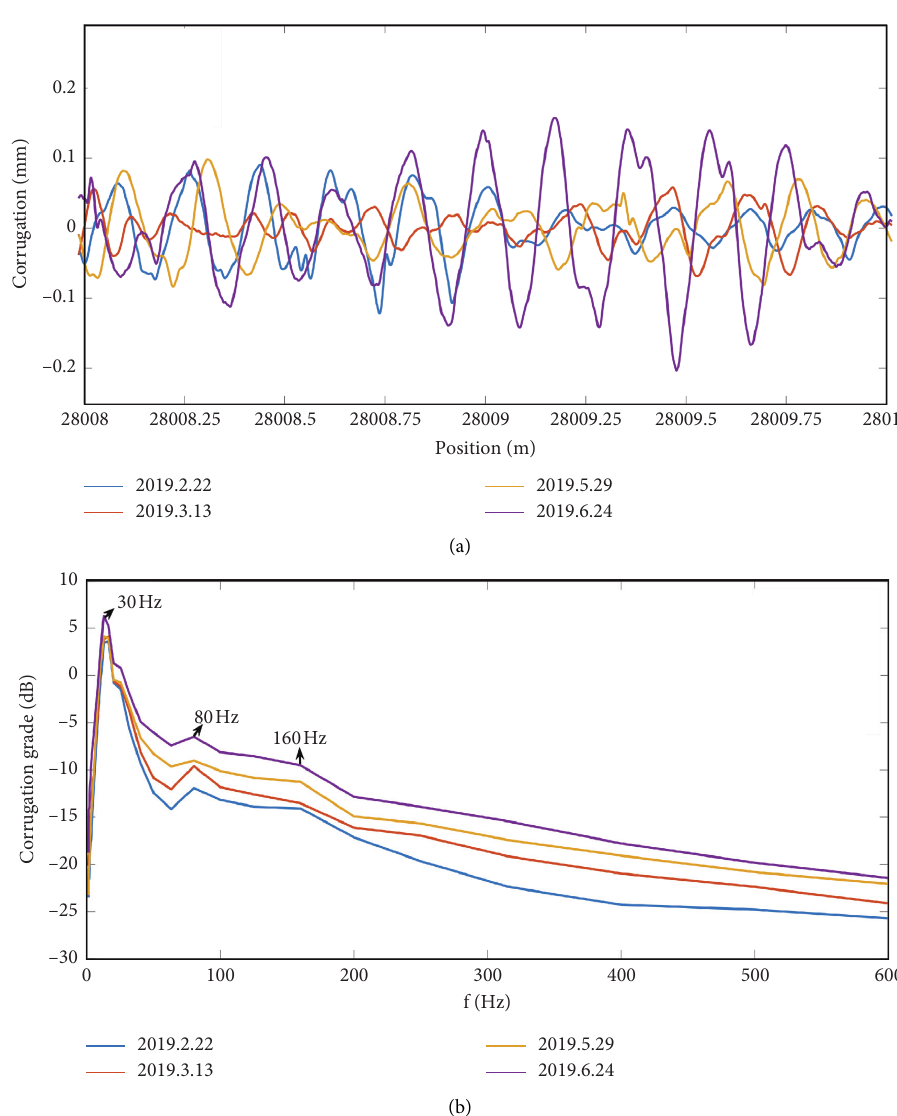
Figure 11: Time-frequency analysis curve of measured corrugation in Shi-Pan down track section. (a) Measurement of local rail wear. (b) One-third octave spectrum curve of measured rail